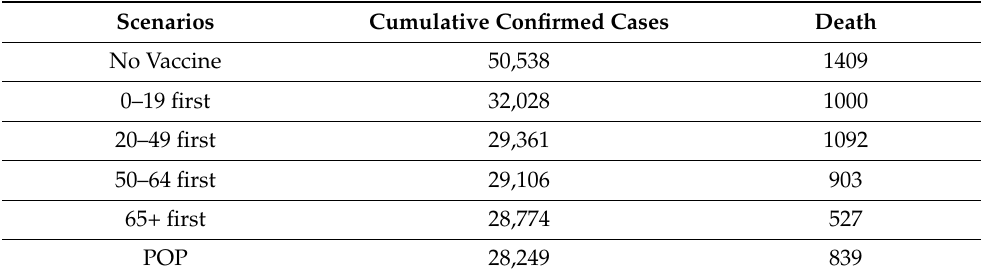
Table 7. Values of cumulative confirmed cases and deaths with SD levels changing adaptively.